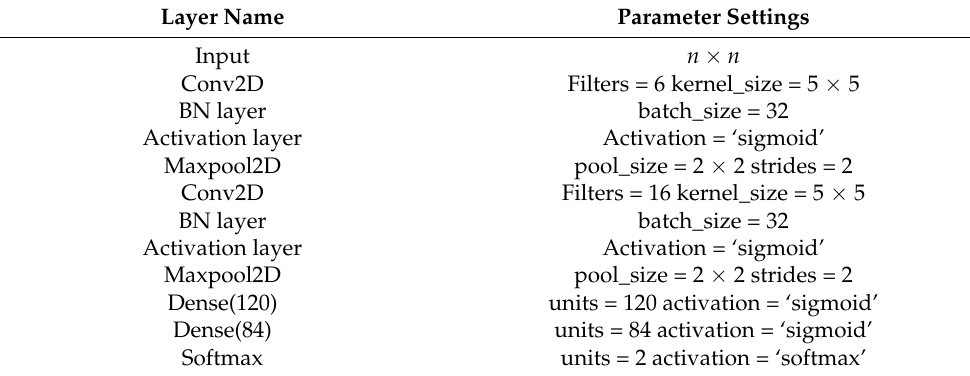
Figure 7. The frame diagram of the convolutional neural network in this paper. Table 1. The parameters of the convolutional neural network in this paper.